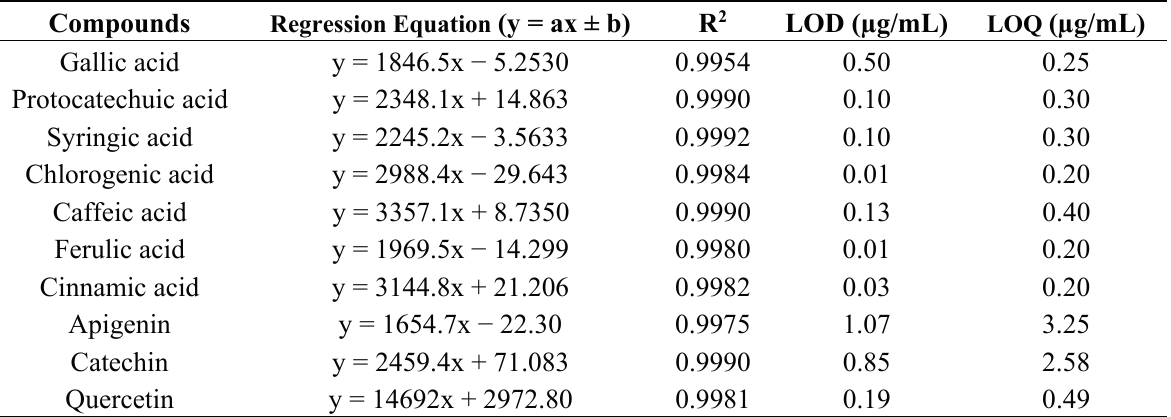
Table 5 Analytical characteristics for determination of phenolic